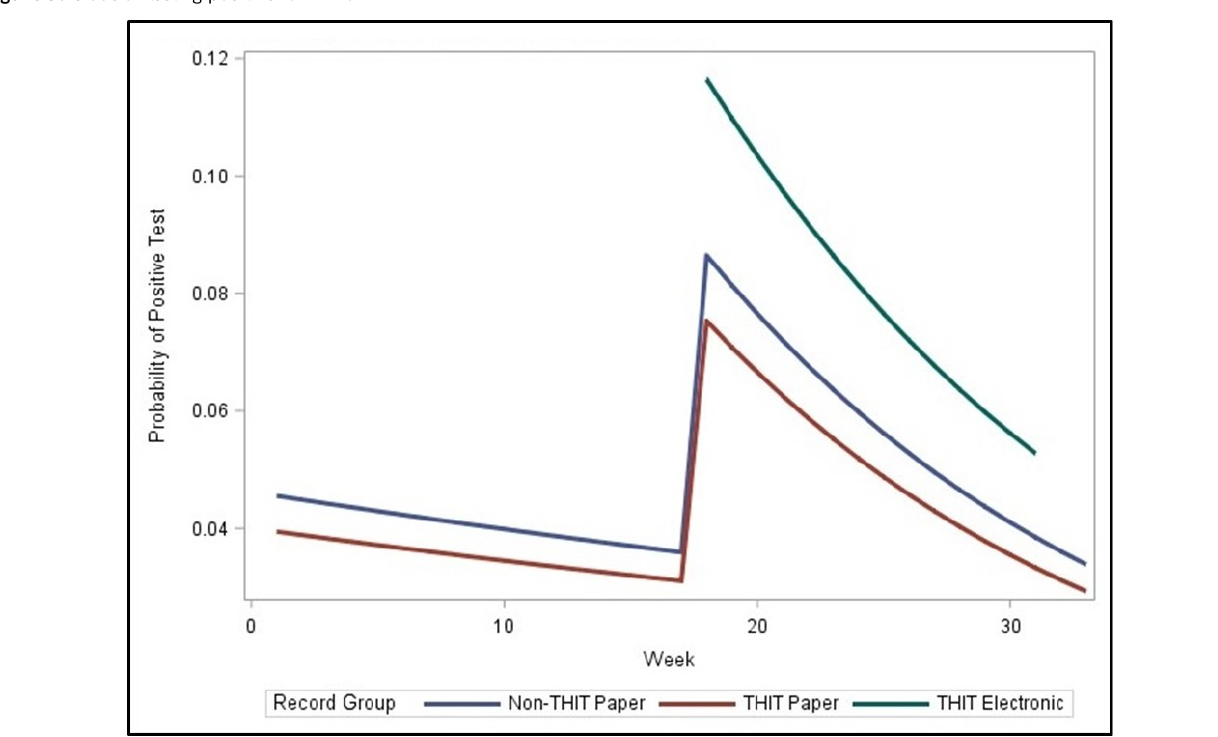
Figure 3. Odds of testing positive for